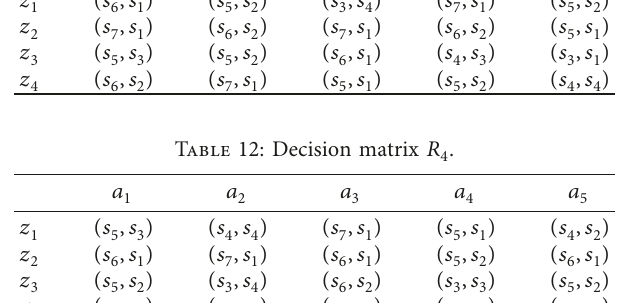
Table 13: Normalized decision matrix R